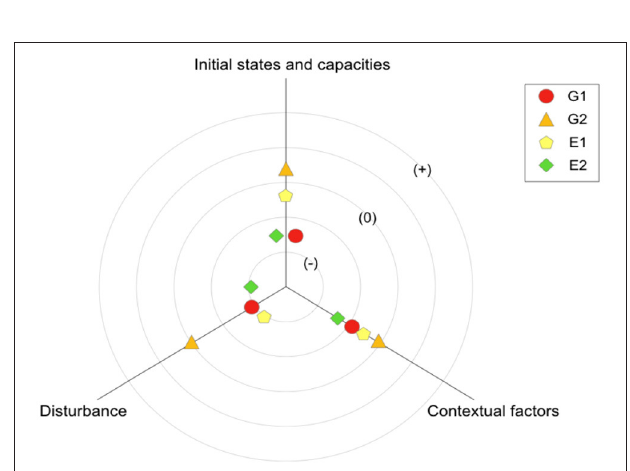
FIGURE 3 | Summary result for baseline resilience based on resilience framework indicator categories for four cases E1, E2 G1, G2. ( − ) decreases the resilience of the system; (0) does not impact the resilience of the system, negatively or positively; ( + ) positively impacts the resilience of the